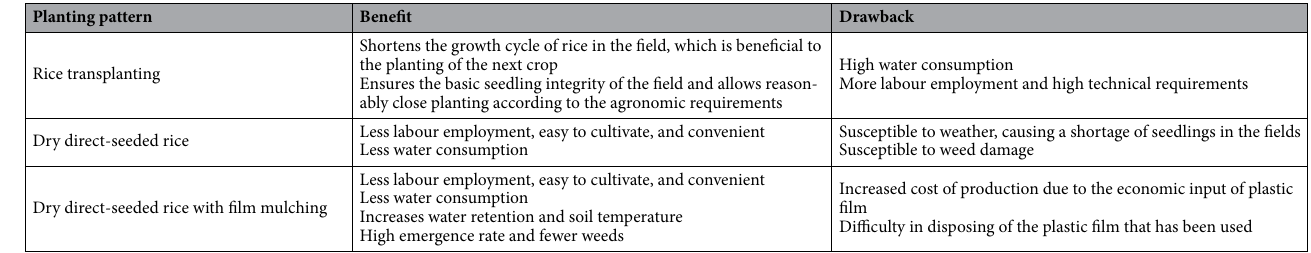
Table 1. Benefits and drawbacks of different planting